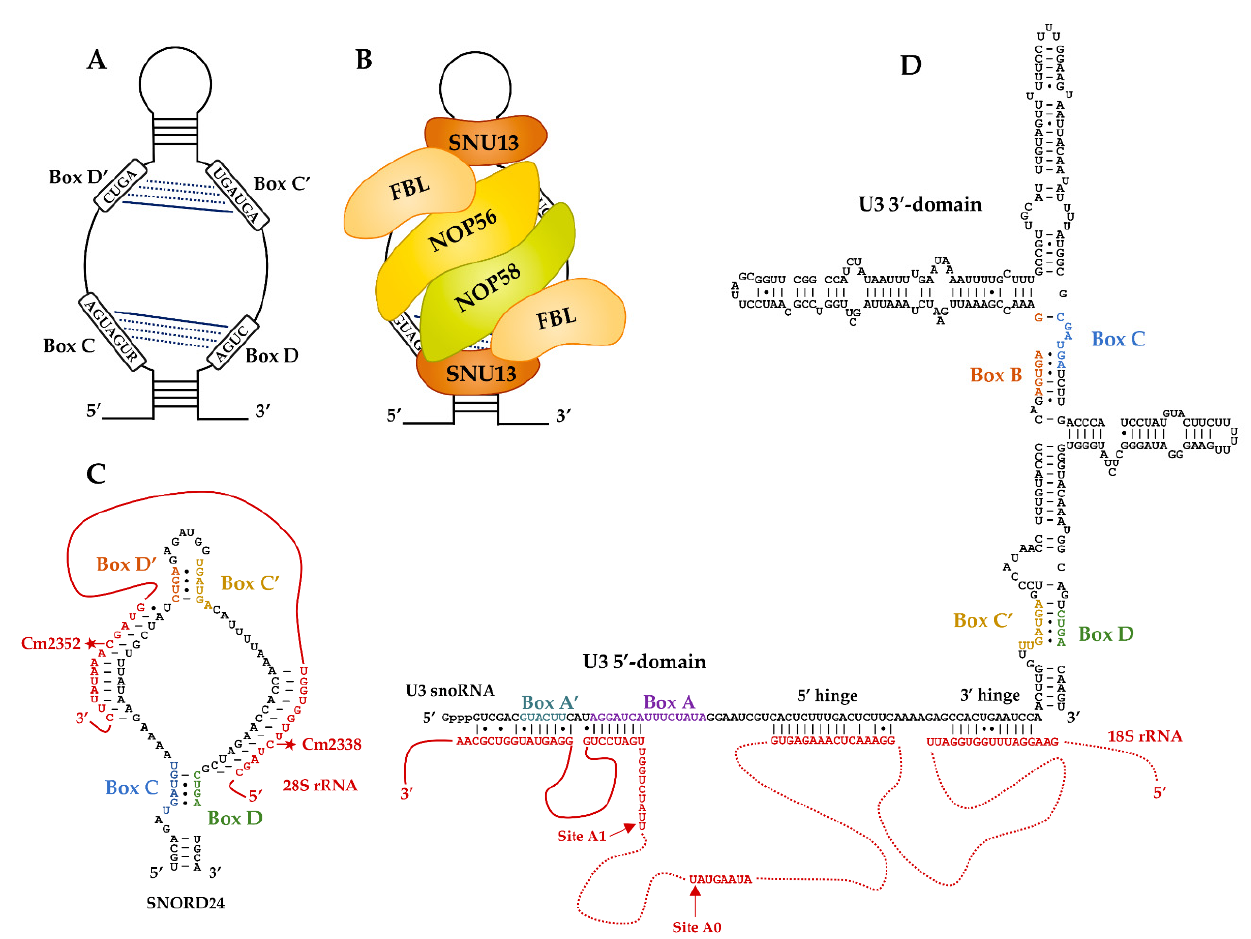
Figure 1. Schematic overview of guide box C/D small nucleolar ribonucleoproteins (C/D snoRNPs) and their target RNAs. ( A ) Box C/D small nucleolar RNAs (C/D snoRNAs) contain conserved sequences called C/D and C (cid:48) /D (cid:48) boxes that fold into a kink-turn (K-turn) containing Watson–Crick pairings (solid blue lines) and non-canonical pairings U:U, G:A, and A:G (dotted blue lines). ( B ) Conventional C/D box snoRNPs associate a C/D snoRNA with the core proteins Nop1p/Fibrillarin (FBL), Nop58p/NOP58, Nop56p/NOP56 and Snu13p/SNU13 in Saccharomyces cerevisiae and Human, respectively. FBL is the methyltranferase that catalyzes the 2 (cid:48) -O-methylation of target RNAs. ( C ) Schematic representation of the bidimensional human SNORD24 structure (adapted from [50]). This snoRNA guides the 2 (cid:48) -O-methylation of 28S rRNA at positions C2338 and C2352. Classically, the methylated nucleotide (red star) hybridizes with the nucleotide located at the fifth position upstream of the D and D (cid:48) box sequences. ( D ) Schematic representation of the bidimensional U3 snoRNA structure and its association with pre-18S rRNA in Saccharomyces cerevisiae (adapted from [61,62]). U3 contains two C/D-like motifs called C (cid:48) /D and B/C boxes that fold into a K-turn recognized by the Snu13p core protein [14]. In addition, the B/C motif recruits Rrp9p (U3-55K in humans) that is essential for 18S rRNA processing. The A/A (cid:48) motifs and the 5 (cid:48) /3 (cid:48) hinges, located in the 5 (cid:48) terminal domain of U3, hybridize with the 18S rRNA (solid red lines) and the 5 (cid:48) ETS (external transcribed spacer, dotted red lines) of the 35S pre-rRNA, respectively. The base-pairing is located near the A0 and A1 pre-rRNA cleavage sites and is essential for the processing of 18S rRNA.